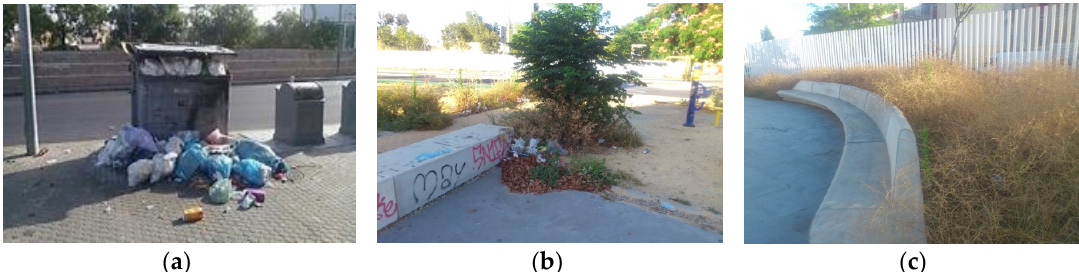
Figure 4. Neglect from public services. ( a ) “The local waste management office is only 20 meters away. They clean this area ever eight or nine days, the trash does not fit inside”. ( b ) “Here we can see the neglect of the city council in regards to parks and gardens. They never come to garden and trash just accumulates”. ( c ) “A big problem we have here in the Poligono Sur is the vegetation, here we do not have gardeners or anything with the consequences of fleas, rats, mosquitos, spiders, and it is incredible. You cannot see anything…you cannot see the plaza”.